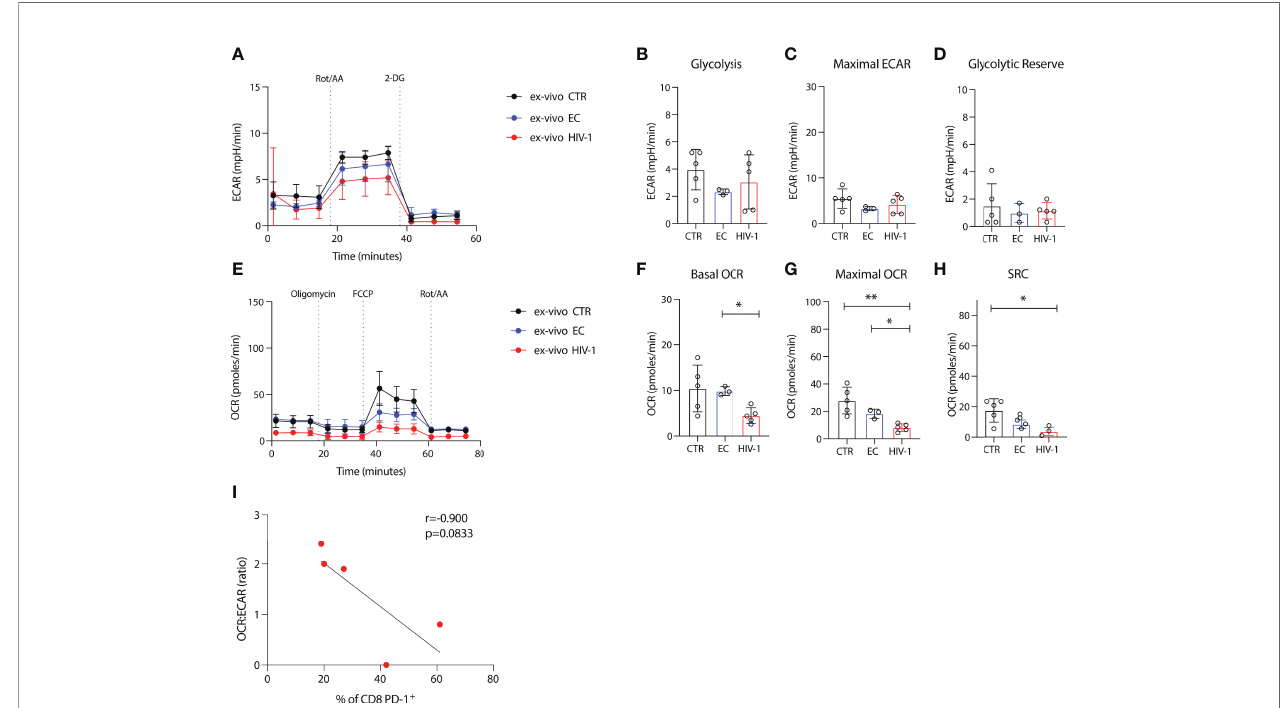
FIGURE 3 | Depressed oxidative phosphorylation in CD8 T cells in viraemic HIV-1 infection. (A) Cellular extracellular acidi fi cation rate (ECAR) of puri fi ed CD8 T cells measured in real time ex-vivo (B) Glycolysis, (C) Maximal ECAR, and (D) glycolytic reserve in isolated CD8 T cells from n = 5 HIV-1 negative controls (CTR) n = 3 elite controllers (ECs), n = 5 viraemic HIV-1 positive donors (HIV-1). (E) Oxygen consumption rate (OCR) of puri fi ed CD8 T cells measured in real time ex-vivo (F) Basal OCR (G) maximal OCR and (H) Spare respiratory capacity (SRC) in puri fi ed CD8 T cells from n = 5 HIV-1 negative controls (CTR) n = 3 elite controllers (ECs), n = 5 viraemic HIV-1 positive donors (HIV-1). (I) Correlation between percentage of PD-1 + CD8 T cells from n = 5 viraemic HIV-1 positive donors and OCR : ECAR ratio. Sample duplicates were used for Seahorse assays. Signi fi cance determined by Mann-Whitney U test, *p < 0.05, **p <